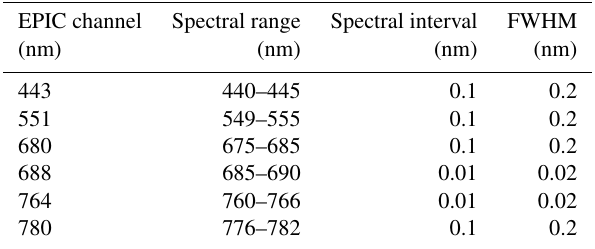
Table 2. Spectral settings of UNL-VRTM for constructing the